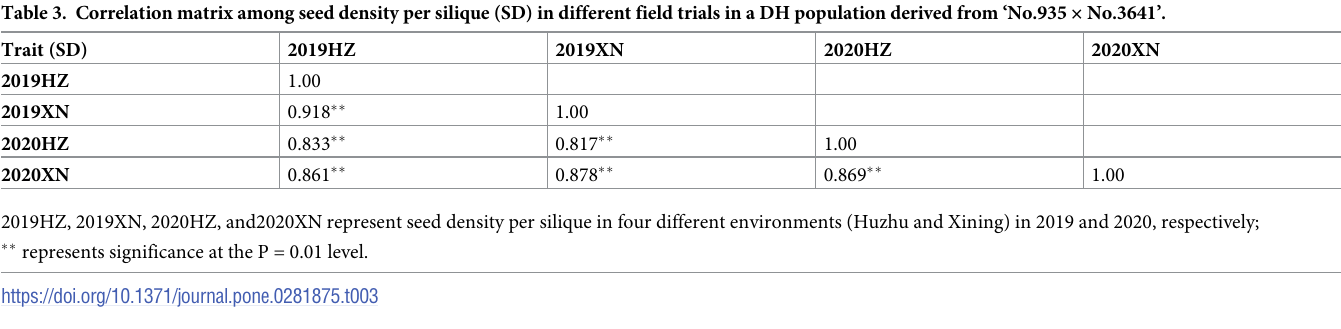
SD was extremely significantly positively correlated with YP and SPS in all 4 environments. In